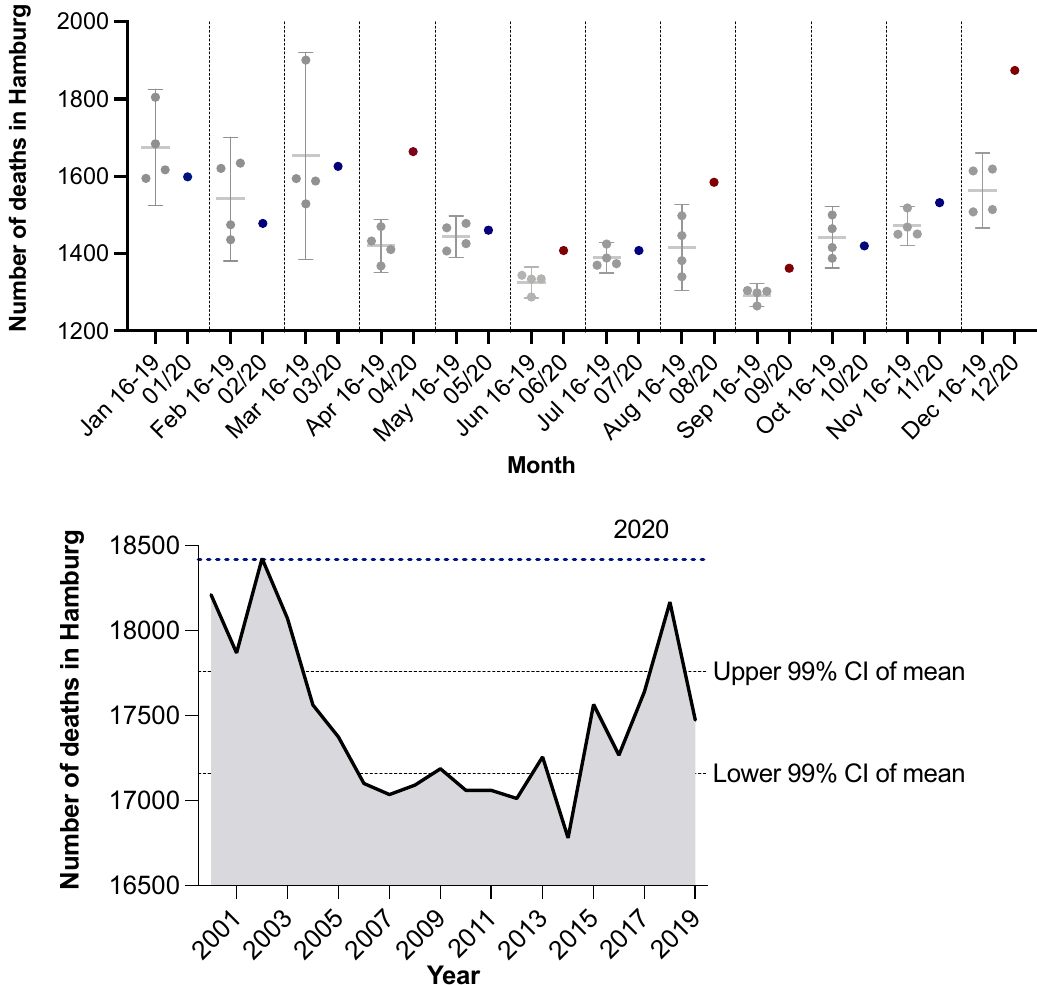
Figure 2. Number of deaths in general in Hamburg. Top: comparison of the monthly number of deaths in 2020 with the monthly average of 2016–2019, displayed with 95% confidence interval (CI) of the mean, blue dots for 2020 numbers within and red dots outside this CI. Bottom: comparison of the annual number of deaths between 2000 and 2019 with 99% CI of the mean as greyish dotted lines and the total number for 2020 with 18,417 fatalities in dotted blue line. Underlying data was available at the Federal Statistical Office Germany (DESTATIS) 11